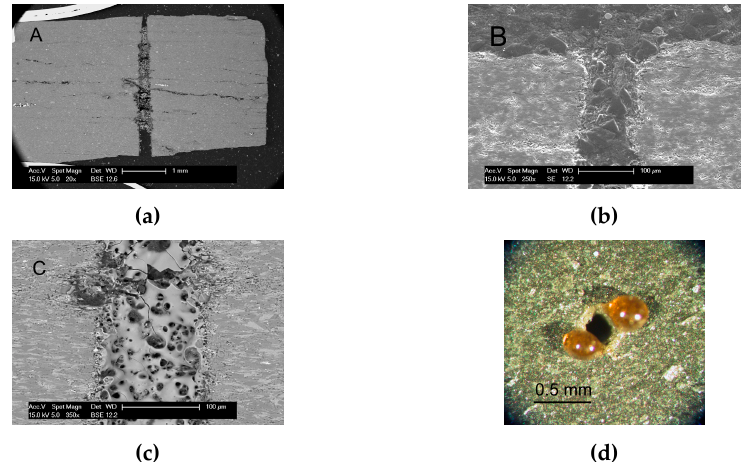
Figure 5. SEM images of the cross-section of a hole produced under optimized processing parameters: ( a ) overall view; ( b ) detail of the exit surface; ( c ) detail of the resolidified material; ( d ) Optical micrograph showing some resolidified dross adhered to the exit side of a hole.